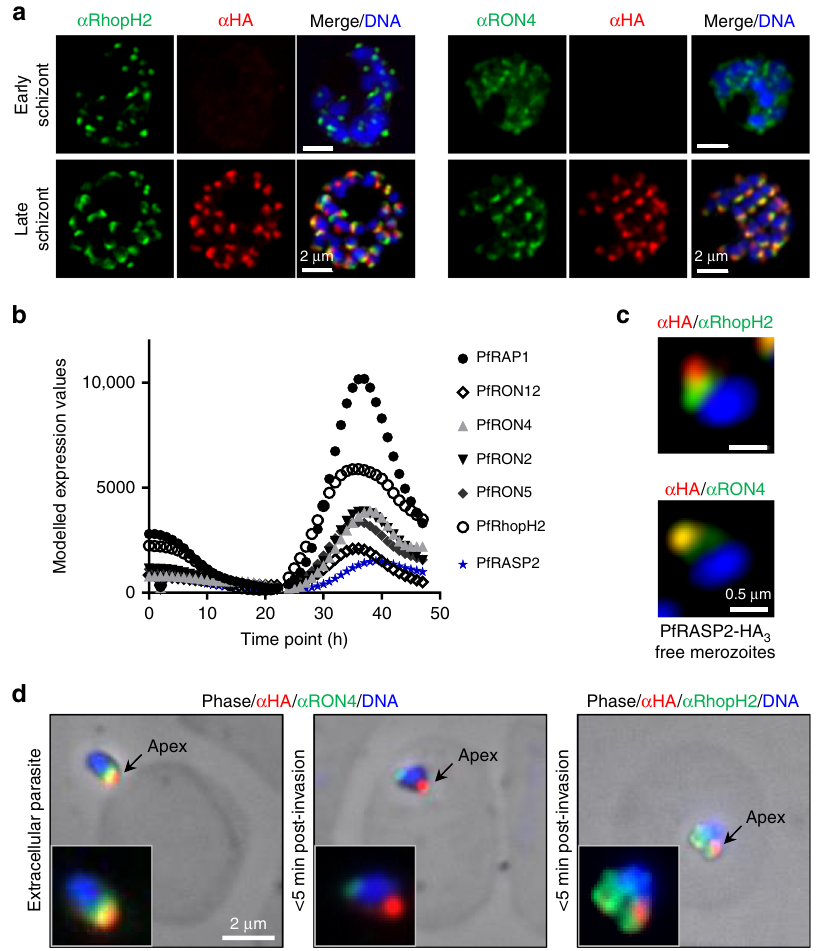
Fig. 3 Plasmodium falciparum RASP2 expression and localisation in erythrocytic stage. a IFAs on PfRASP2-HA 3 schizonts showing PfRASP2-HA 3 with rhoptry markers. RON4, rhoptry neck, RhopH2, rhoptry bulb. b Comparison of the expression patterns of known rhoptry proteins during the P. falciparum erythrocytic cycle in combination with the expression pro fi le of PF3D7_0210600 (PfRASP2). Real-time transcription data of the P. falciparum 3D7 strain obtained by biosynthetic pyrimidine labeling (PlasmoDB.org). c IFAs of PfRASP2 in free merozoites. d IFAs of invading merozoites. Left, extracellular parasite attached to red blood cell. Middle, at early point of invasion, the RON4 marker detects the moving junction at the posterior end of the intracellular merozoite, while RASP2 remains apical. Right, export of the bulb marker RhopH2 upon invasion. c Pictures of individual merozoites where acquired with a confocal microscope with